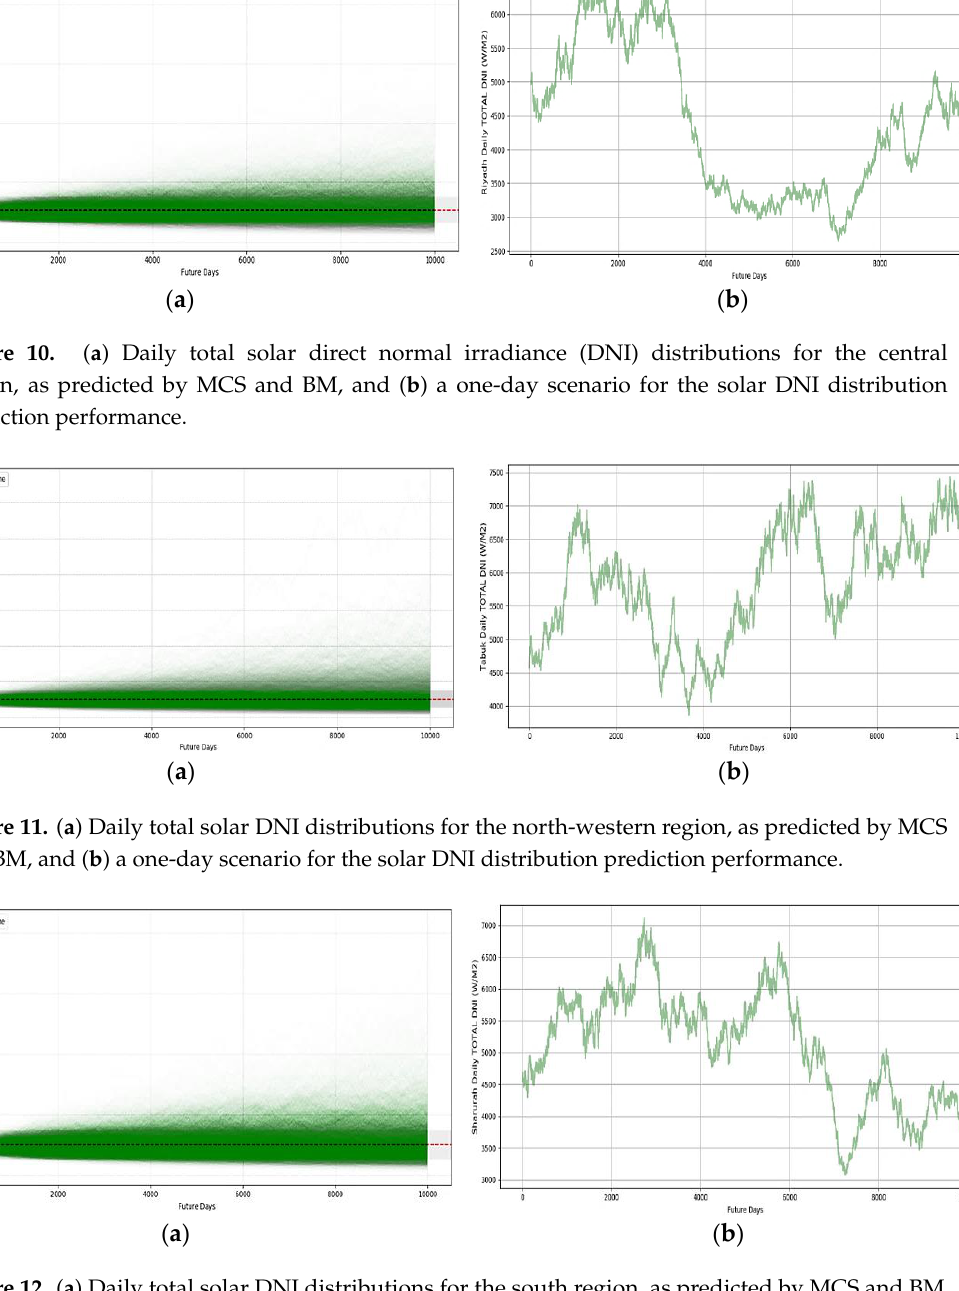
and ( b ) a one-day scenario for the solar DNI distribution prediction performance.